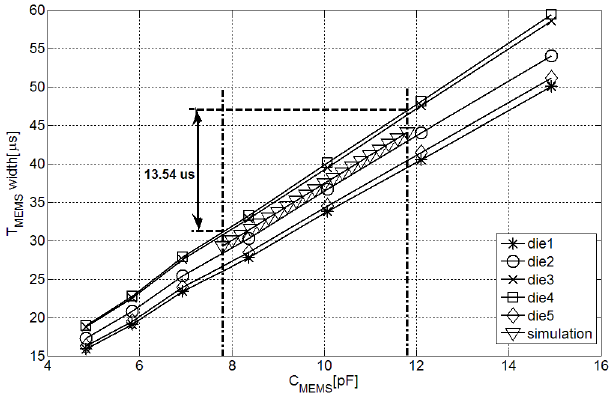
Figure 5. Measurement-pulse length in the fabricated interfaces with different C